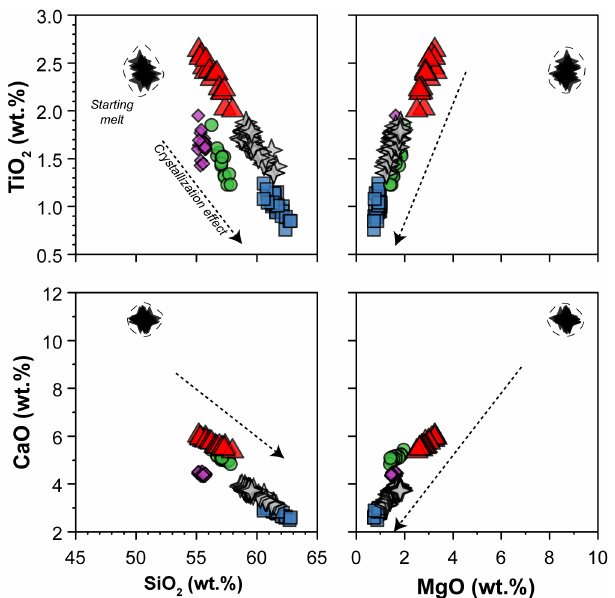
Figure 4. SiO 2 and MgO vs. CaO and TiO 2 contents (in wt%) of glasses (normalized anhydrous to 100wt%) after crystallization ex- periments. The black stars (within the dashed field) show the com- position of the starting material. The arrows represent the effect of clinopyroxene plus amphibole crystallization on the composition of the evolving melts during crystallization experiments. Symbols are as in Fig. 3.